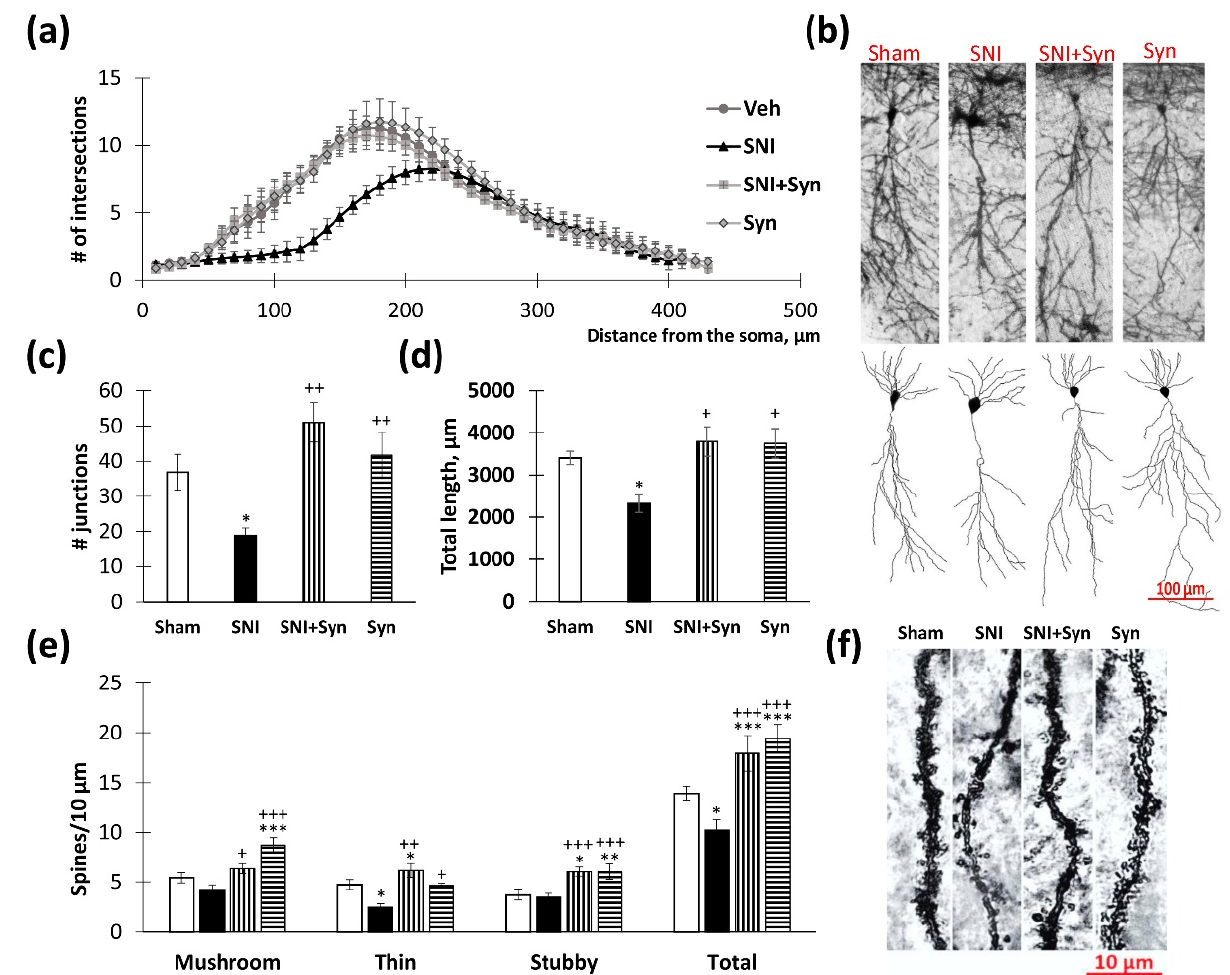
Figure 3. The results of dendrite Sholl analysis and spines density measurement. ( a ) The number of intersections along the apical dendritic trees at all distances from the soma in CA1 pyramidal neurons, Mean ± SEM, n = 5 (number of animals). ( b ) Representative images of CA1 pyramidal neurons in the contralateral dorsal hippocampus of mice with neuropathic pain and synaptamide treatment. ( c ) The number of junctions along the apical dendritic trees at all distances from the soma of CA1 pyramidal neurons, n = 5 (number of animals). ( d ) The total length of apical dendrites in CA1 pyramidal neurons, n = 5 (number of animals). ( e ) The density of dendritic spines in the apical dendrites of the CA1 pyramidal neurons. ( f ) The images of CA1 pyramidal neurons stained by the Golgi–Cox method, mean ± SEM, n = 10 (number of analyzed neurons per group), * p < 0.05, ** p < 0.01, *** p < 0.001 (compared to “Sham”), + p < 0.05, ++ p < 0.01, +++ p < 0.001 (compared to “SNI”).